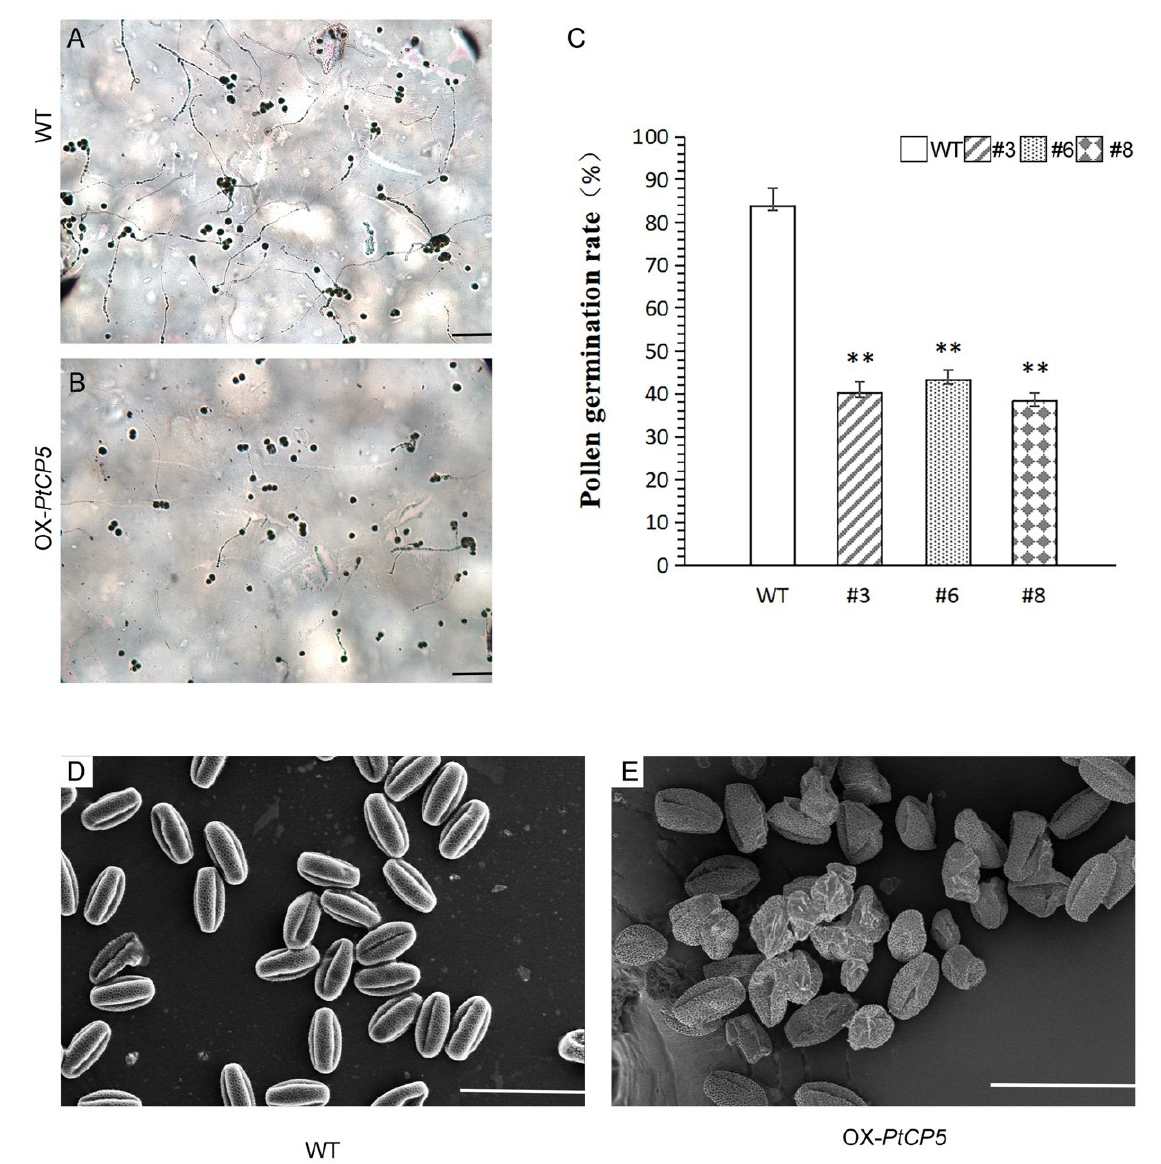
Figure 6. Pollen of OX-PtCP5: ( A , B ) pollen germination of OX-PtCP5 and wild-type, bar = 500 μ m. ( C ) Pollen germination rate. Pollen samples number of OX-PTCP5 and wild-type were 200 each. ** Represents extremely significant difference between OX-PTCP5 and wild-type ( p < 0.01). ( D , E ) Pollen of wild-type and OX-PtCP5 Arabidopsis by scanning electron microscope, bar = 100 μ m.